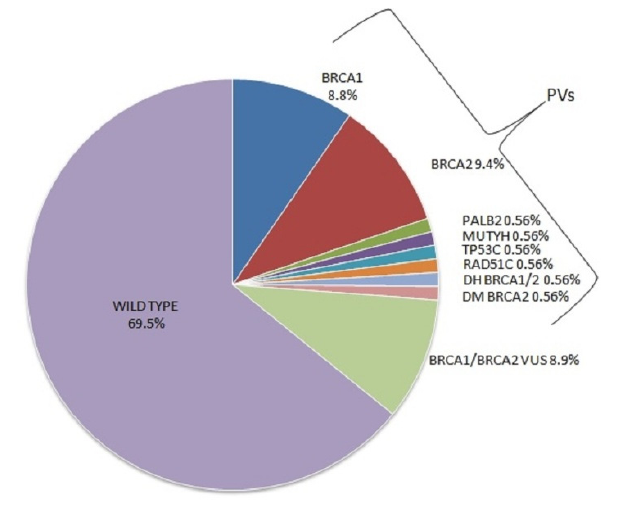
Figure 1. Pathogenic variants and VUS found in HBOC